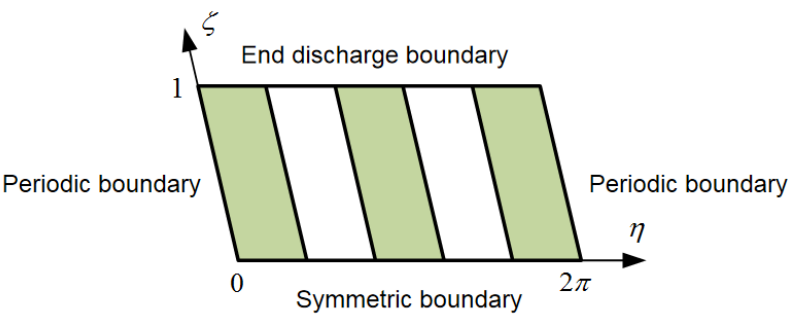
Figure 6. Schematic diagram of the boundary of the herringbone grooved journal bearing.